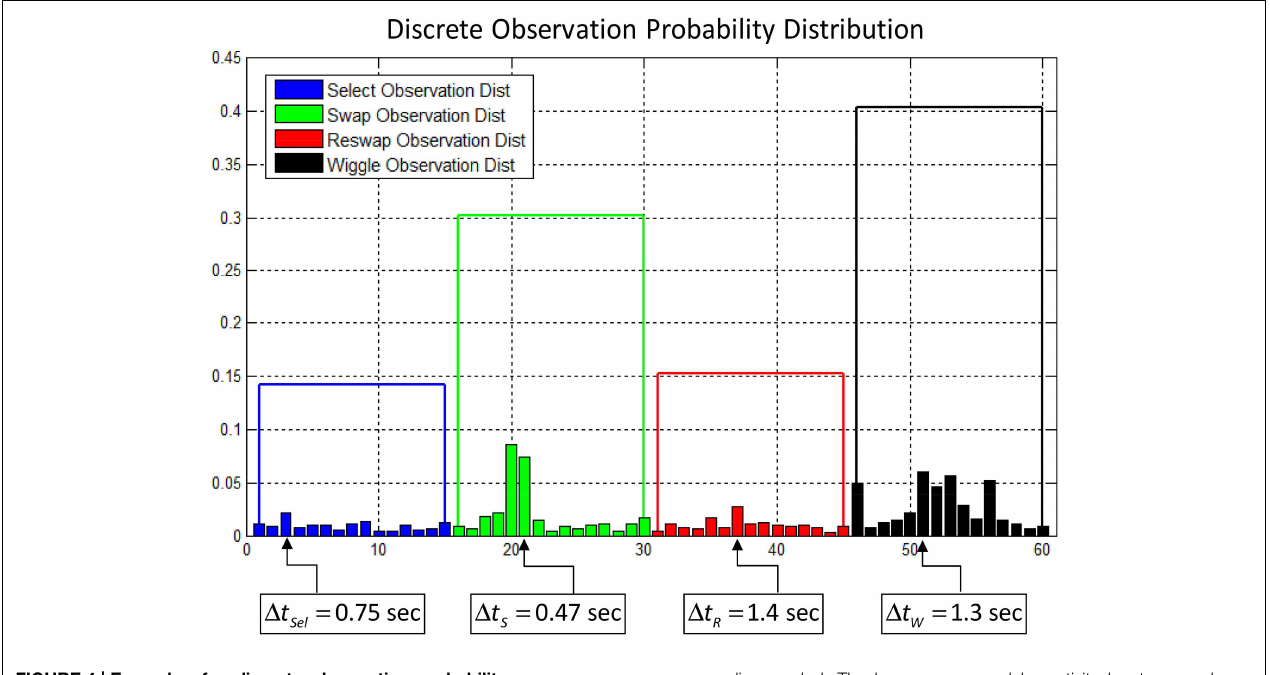
FIGURE 4 | Example of a discrete observation probability distribution of the 60-symbol alphabet used to encode the activity logs and temporal features. Each small bar corresponds to a centroid representing a range of temporal inter-activity values. The height of the bar represents the relative probability of observing the